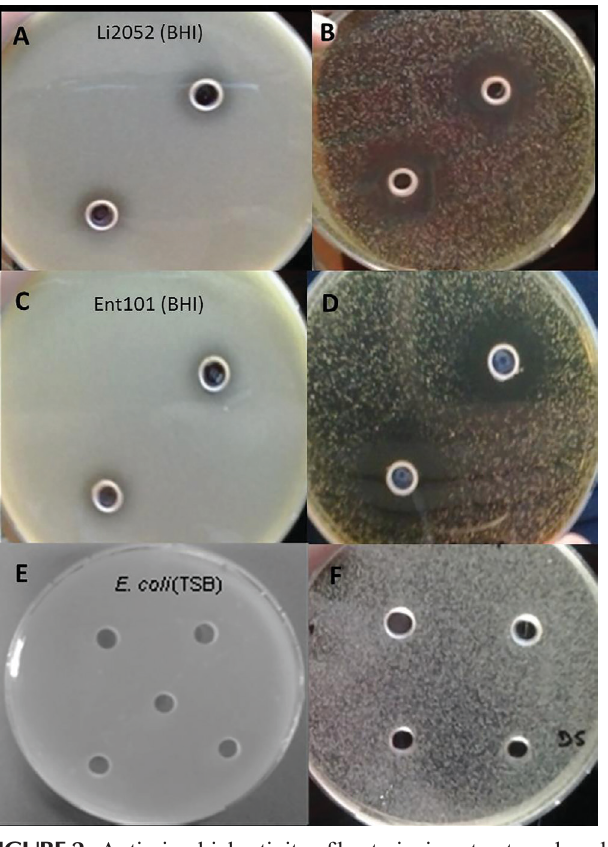
FIGURE 2 - Antimicrobial activity of bacteriocin extract produced by Pediococcus pentosaceus ATCC 43200 after 24 h of cultivation in G-MRS medium against Listeria innocua 2052 (Li2052), Enterococcus 101 (Ent101) and Escherichia coli ATCC 25922 ( E. coli ). Tests were performed by agar-well-diffusion assay carried out on BHI (Enterococcus and Listeria strains) and TSB ( E. coli ) agar-media. (A, C, E = indicator strain at OD 0.3); (B, D, F = indicator strain diluted 100 times from OD 0.3).